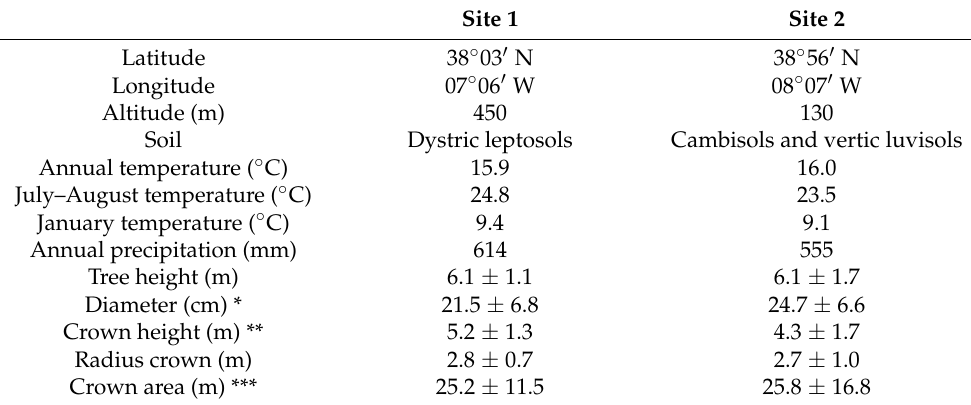
Table 1. Description of sites and Quercus rotundifolia Lam. trees sampled in each site. Average of ten trees and standard deviation. Average annual values for the climatic data (period